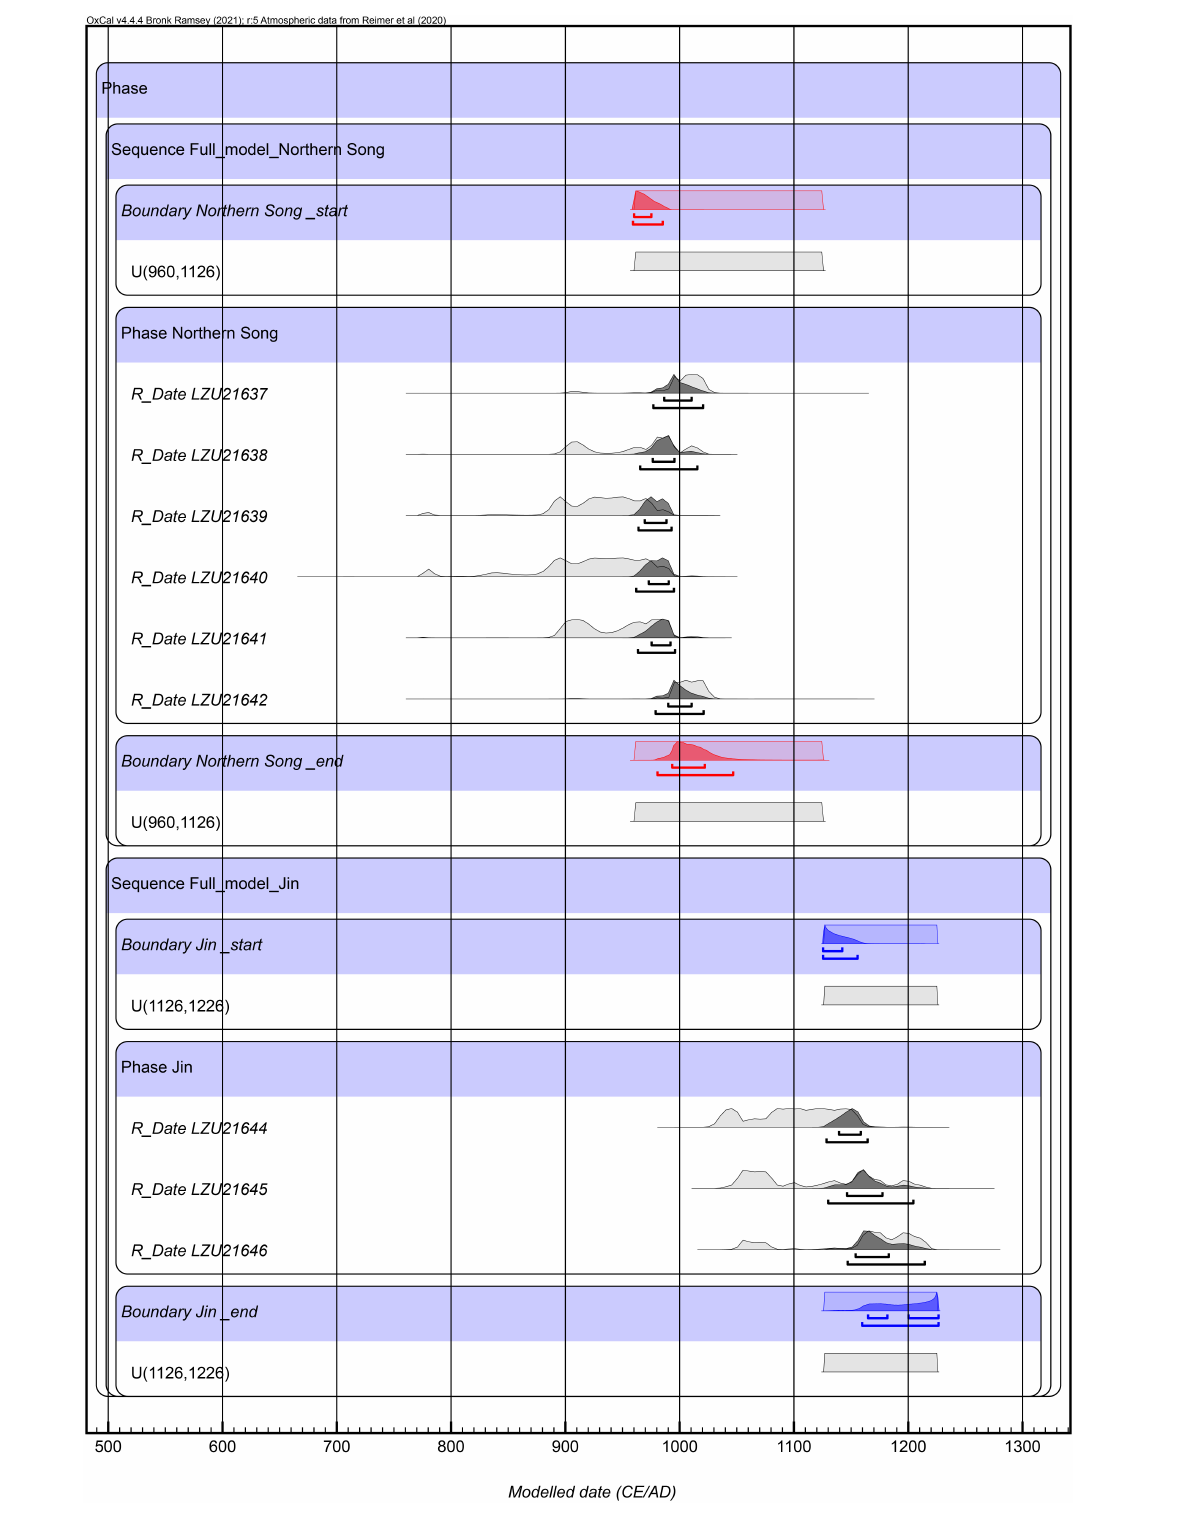
Frontiers in Plant